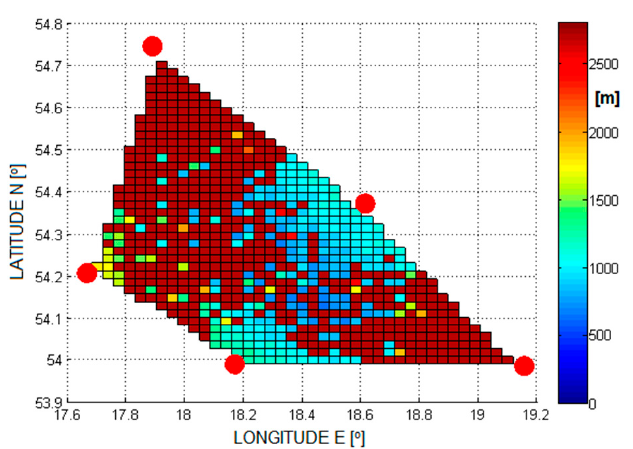
Sensors 2021 , 21 , x FOR PEER REVIEW 12 of 28 Figure 7. The RMSE of 2D position estimation in (m) for the SI algorithm (TDoA error is ±5 μ s). Figure 7. The RMSE of 2D position estimation in (m) for the SI algorithm (TDoA error is ±5 μ s). Figure 7. The RMSE of 2D position estimation in (m) for the SI algorithm (TDoA error is ± 5 µ s).